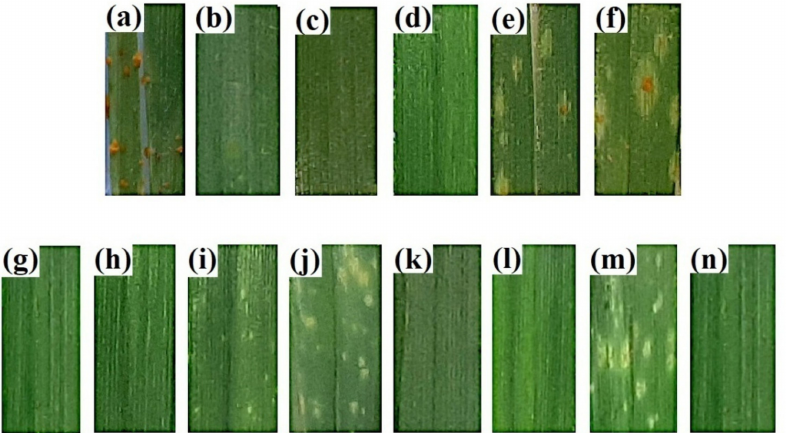
Figure 1. Development of stem rust on wheat ( a – f ) and rye ( g – n ) seedlings: ( a )—cv. Pamyati Azieva; ( b )—line Tc Lr26 / Sr31 ; ( c )—cv. Kavkaz; ( d )—cv. Seri 82; ( e )—cv. Bacanora; ( f )—cv. PWB343; ( g )—